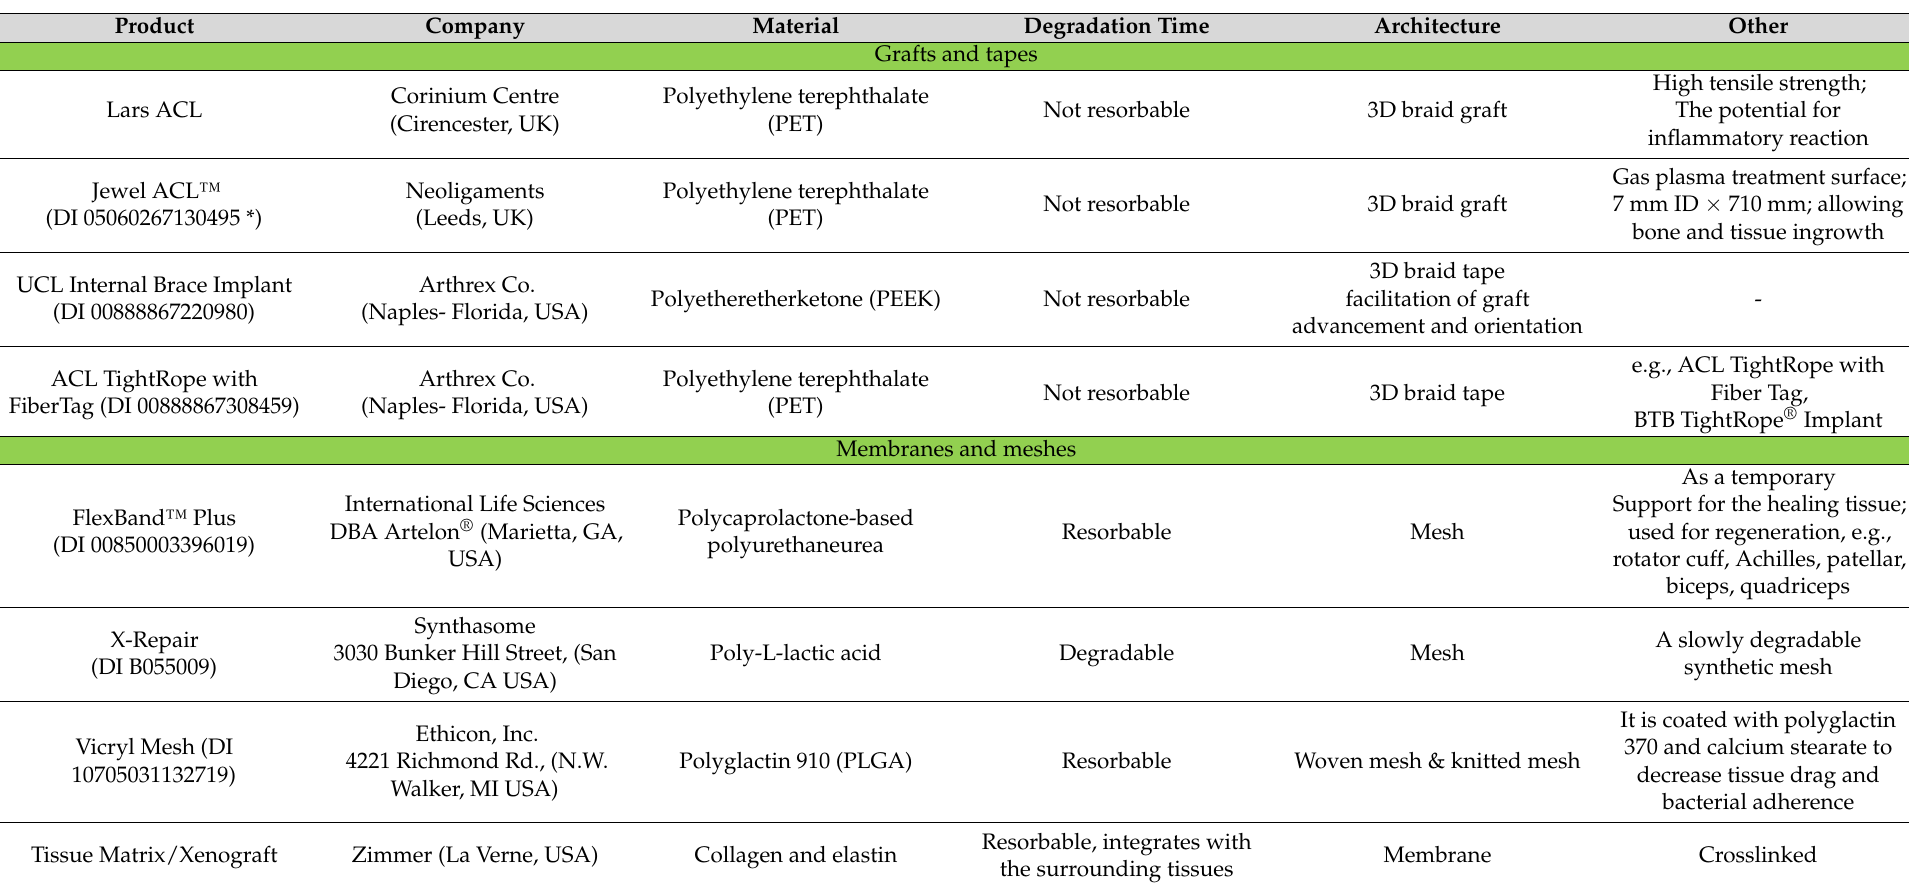
Table 2. Bio-based and synthetic polymer-based grafts and patches for ACL reconstruction/repair available on the market (data comes from the official website